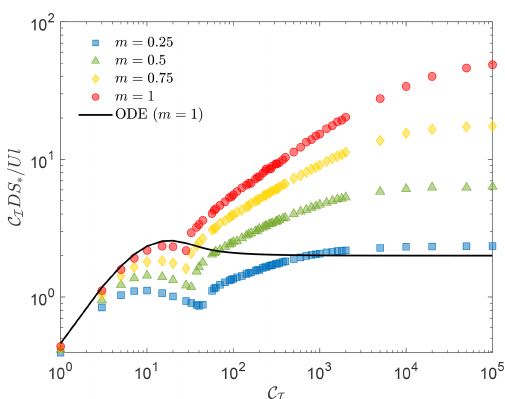
Figure 6. Average sediment partitioning according to Eq. (32) as a function of the channelization index for different values of m . Points refer to numerical simulations and solid line refers to the analytical solution for the unchannelized regime (courtesy of Sara